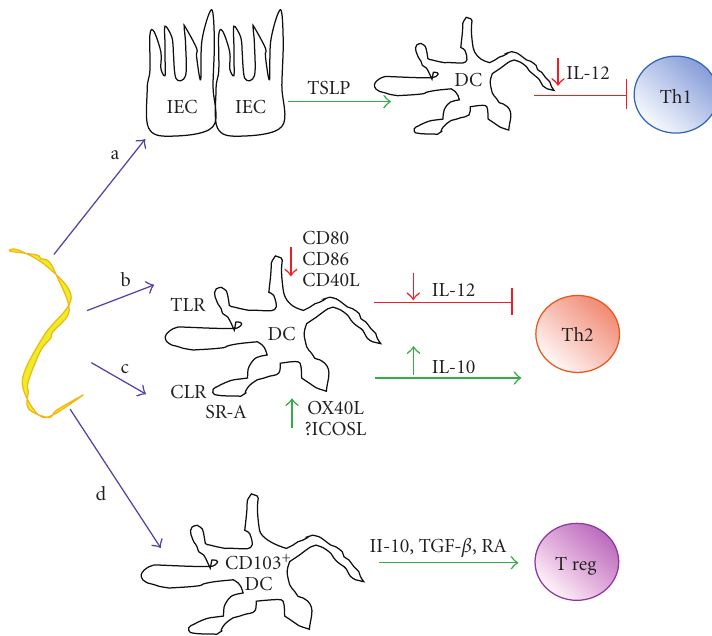
Figure 1: Helminth E/S products are able to act on intestinal epithelial cells (IECs) inducing TSLP that engages with the TSLP receptor on DCs and inhibits IL-12/p40. (a) Some E/S products are able to induce signaling through TLRs directly on DCs, resulting in the inhibition of this Th1-promoting cytokine. (b) On the other hand, Th2 responses could be promoted through interactions of helminths with other pattern recognition receptors such as C-type lectins (CLR) or scavenger receptor-A (SR-A) and induction of costimulators such as OX-40L that result in Th2 promotion. (c) Finally, interaction with CD103 + DCs may result in the induction of T regs through TGF- β and retinoic acid (RA) production. (d) The question of whether di ff erent subsets are responsible for these phenomena remains to be